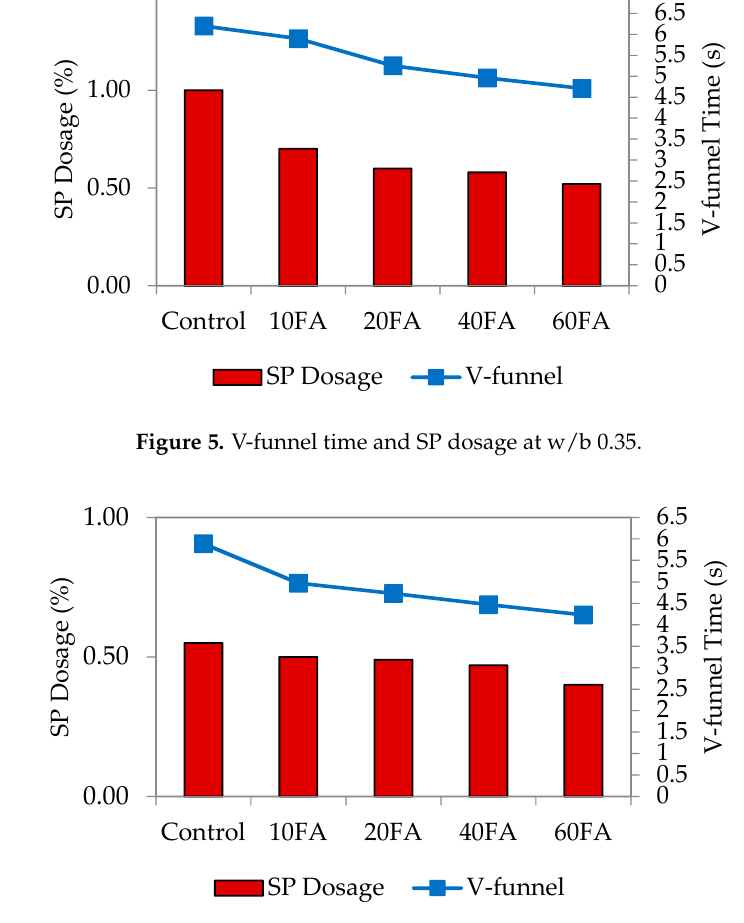
Figure 6. V-funnel time and SP dosage at w/b 0.40.